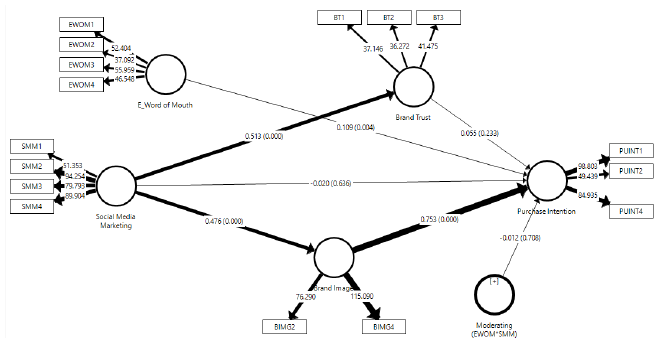
Fig. 3. Structural model depicting direct, indirect and moderation effect value with regression coefficients.